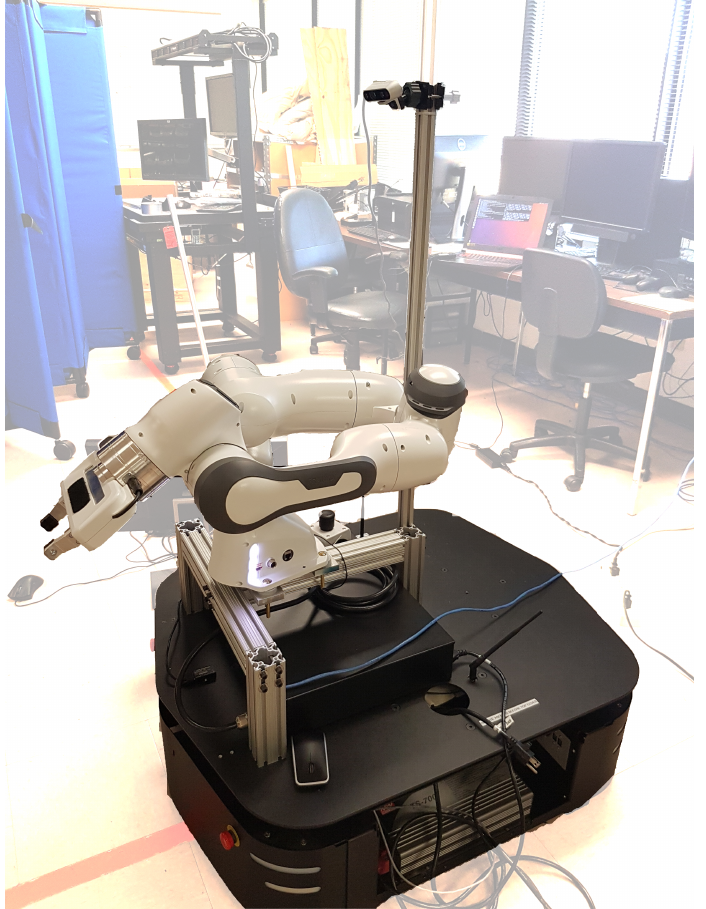
Figure 2. The MINA robot (highlighted) consists of a Franka Emika Panda robot manipulator mounted on a Clearpath Ridgeback mobile base. Sensors include LiDARs and an RGBD camera. Both the Panda arm and Ridgeback mobile base have drivers for the Robot Operating System (ROS). We leveraged the ROS for integration and control [34], in order to leverage its large community and open-source packages. One such package is Moveit, which is used to calculate forward and inverse kinematics, collision-free joint trajectories, and visualization data. The ROS runs on an internal computer in the Ridgeback mobile base. Due to the computational load of perception, mapping, navigation, and object detection, two laptops running additional ROS threads were carried as the payload by the Ridgeback. The consolidation of the computation is an avenue of future